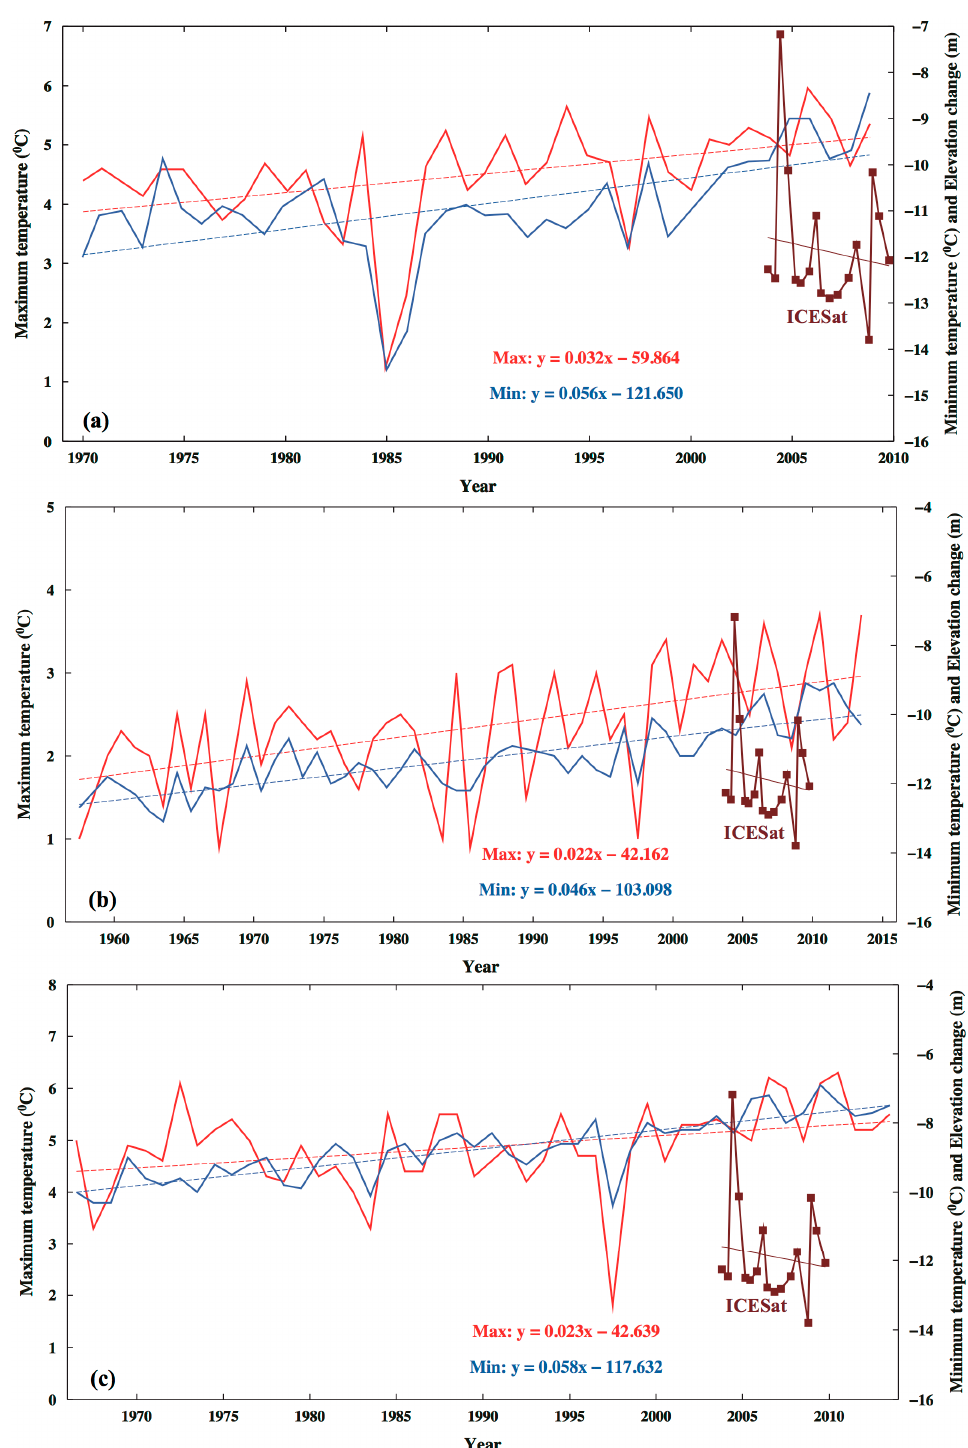
Figure 9. Mean annual maximum temperatures (red) and minimum temperatures (blue) at ( a ) Tuotuohe weather station over 1979–2009; ( b ) Wudaoliang weather station over 1957–2013; and ( c ) Anduo weather station over 1966–2013, fitted by lines described in Figure 8. Overlapped in ( a – c ) are elevation changes from Figure 4, shifted by 10 m. The vertical labels on the right are for mean annual minimum temperature and shifted elevation change.